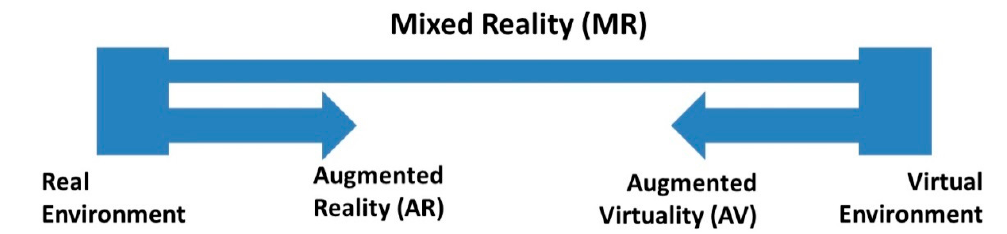
Figure 4. Simplified representation of a RV Continuum. Produced by authors adapting source [7].